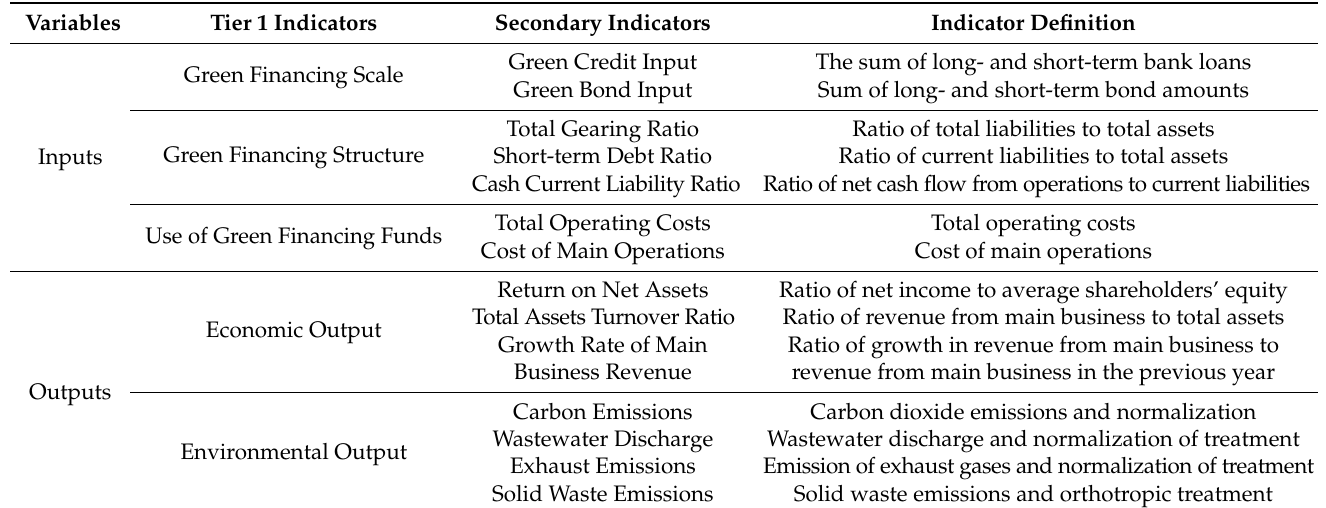
Table 1. Input and output indicators.